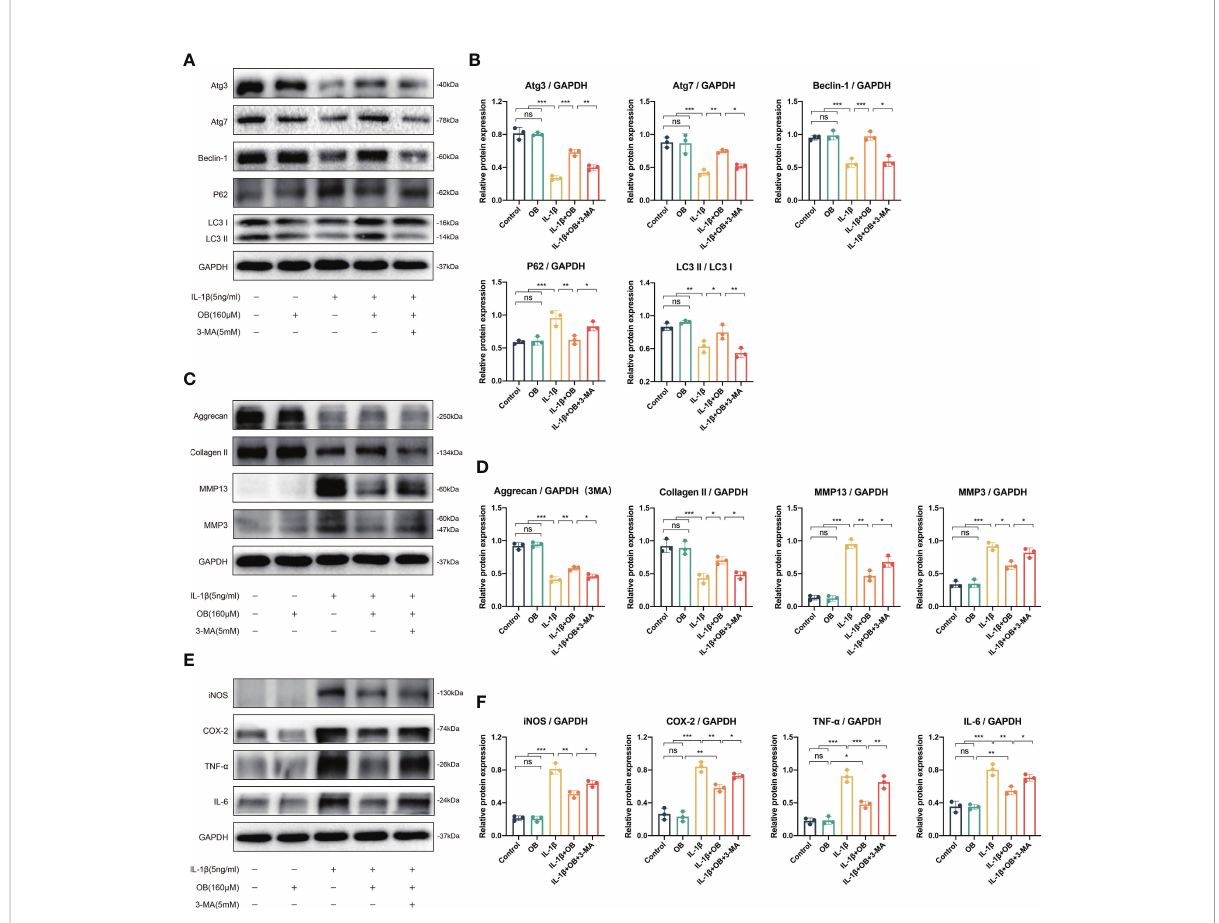
FIGURE 7 3-MA reversed the anti-cartilage degradation and the anti-in fl ammatory effects of OB in IL-1 b – induced chondrocytes. Chondrocytes were administered with IL-1 b (5 ng/ml) or/and OB (160 m M) or/and 3-MA (5 mM)for 24 h. (A) Western blot analysis and (B) quantitative data for autophagy-related proteins (Atg3, Atg7, Beclin-1, P62, and LC3 I/II) in chondrocytes. (C) Western blot analysis and (D) quantitative data for anabolic and catabolic-related proteins (Aggrecan, Collagen II, MMP3, and MMP13). (E) Western blot analysis and (F) quantitative data for in fl ammatory proteins (iNOS, COX-2, TNF- a , and IL-6). Data were presented as means ± SD (n = 3). ns, no signi fi cance; * p < 0.05; ** p < 0.01; *** p <